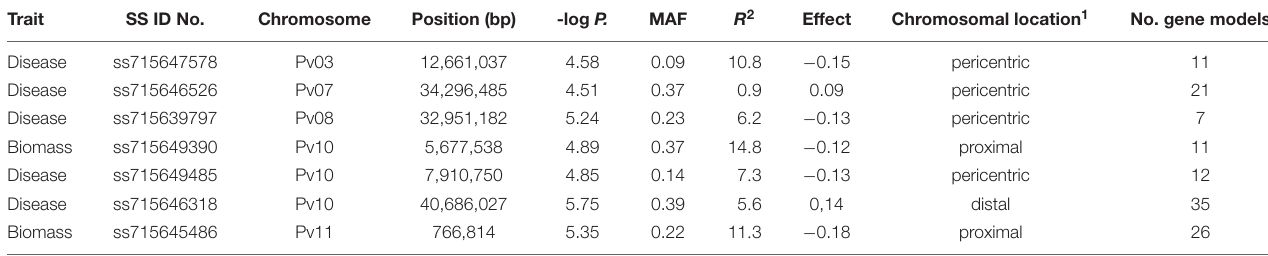
TABLE 5 | SS identification numbers of the SNP, chromosome, position, negative log p -value, minor allele frequency (MAF), proportion of total phenotypic variation explained by the SNP ( R 2 ), allelic effect, chromosomal location and number of gene models found within a 200 kb window proximal and distal to the SNP for significant associations found from genome wide association study of Fusarium solani root rot disease severity and biomass in the BeanCAP Snap Bean Diversity Panel grown at the Oregon State University Vegetable Research Farm in 2014 and 2015. Trait SS ID No.